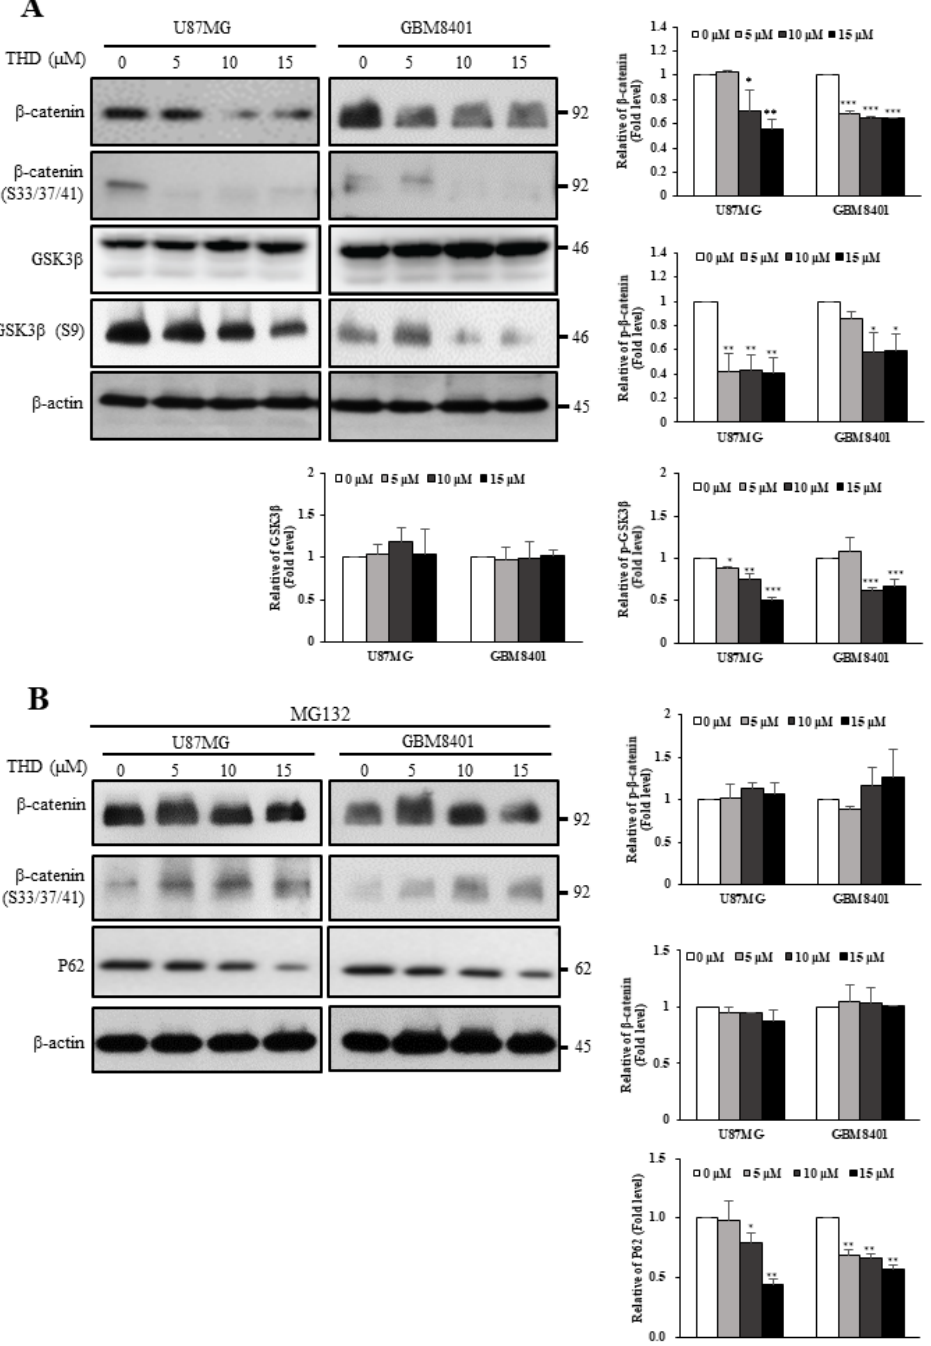
Figure 5. THD mediated β -catenin degradation through Wnt/ β -catenin signaling pathway. ( A ) GBM cells were treated with 5, 10, or 15 µ M THD for 24 h, and the protein expression patterns of the Wnt pathway were determined; ( B ) GBM cells were incubated with different concentrations of THD and MG-132 (10 µ M) for 24 h. Cytosolic fractions were prepared and subjected to Western blotting with GSK3 β , phosphor S9 GSK3 β , β -catenin, phosphor S33/37/41- β -catenin and P62 antibodies. β -actin was used as an internal control. Bar graphs represent the mean of triplicates ± SD. * p < 0.05, ** p < 0.01, *** p < 0.001 compared with the control